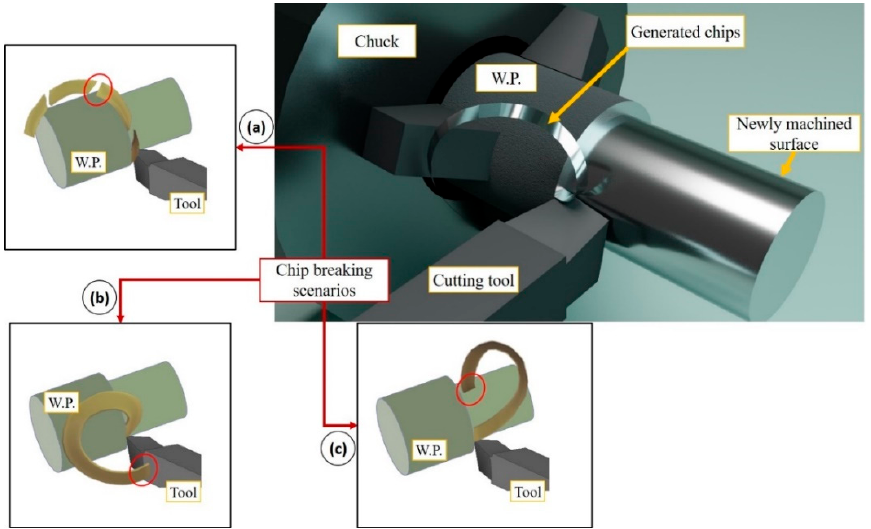
Figure 1. Chip breaking methods ( a ) breaks on its own; ( b ) breaks against the tool; ( c ) breaks against workpiece.